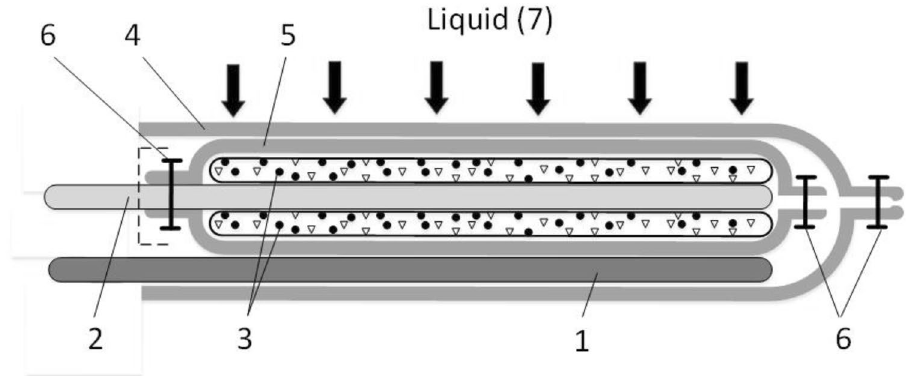
Fig. 1 Flexible textile Al-Air battery cell. 1—aluminium anode, Mtex ® aluminium-textile composite material; 2—cathode current collector, Shieldex ® Budapest conductive textile; 3—carbon granule and optional NaCl mixture to increase its concentration in electrolyte; 4— cotton enclosure of the cell; 5— cotton enclosure of the cathode; 6—sewn joints; 7—activating liquid from outer environment that is applied to the cell and that acts as an electrolyte